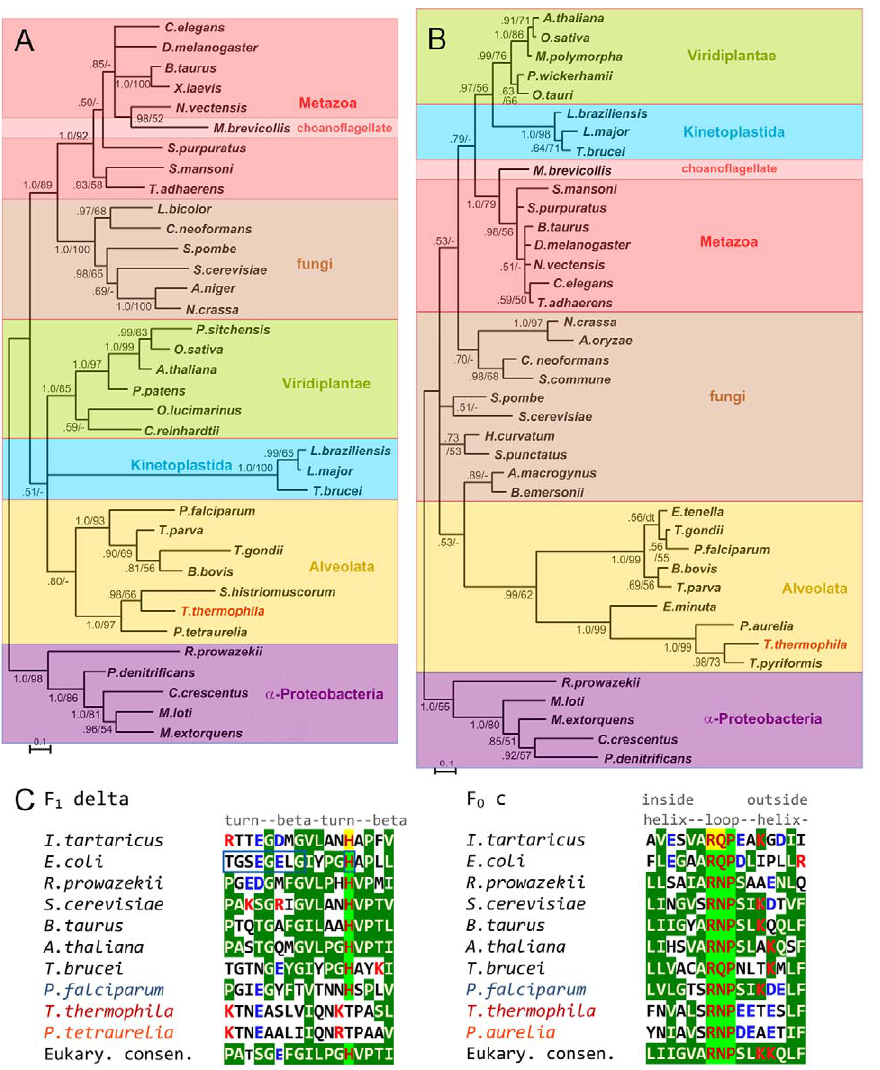
Figure 5. Phylogenetic trees inferred for subunits c and c and alignment of the interface regions of subunits d and c. (A and B) show trees inferred by Bayesian analysis (MrBayes [76], see Methods) for subunit c and subunit c, respectively. Numbers near branch nodes indicate Bayesian posterior probabilities/maximum likelihood bootstrap support (200 replicates) (maximum likelihood analysis employed PhyML [80] [see Methods] indicates a maximum likelihood support of less than 50%; dt indicates a different branch topology was supported by the maximum likelihood analysis). Branches with less than 0.5 posterior probability have been collapsed to a common node. Sequences from a -proteobacterial spp. were included to provide a root, but turned out not to compose the most divergent clade in each analysis; the trees are nevertheless shown as rooted by the bacterial clade. Major taxonomic groups are indicated by color shading (it should be kept in mind, however, that gene product trees can differ from species trees via a number of biological mechanisms, as well as methodological and statistical error). The bar at the lower left provides the scale of substitutions per site. (C) compares the interface regions of subunits d (denoted e in prokaryotes) and c from selected prokaryotic and eukaryotic spp. Amino acid residues determined to be critical for interaction by site directed mutagenesis [49] are shown in dark red with a yellow background. Highly conserved residues are dark red on a light green background; those that are identical to or chemically similar to the consensus amino acid are shown with reverse coloration on a green background. (Consensus residues were calculated in Jalview 2.4 [96] using alignments of representative eukaryotic spp. from a broad range of taxa, but omitting ciliates. Consensus is not indicated for two positions of subunit d that have a very low degree of conservation). Residues of subunit e that were shown to be in proximity to the loop region of subunit c by cross-linking in the E. coli complex [48,97] are enclosed in boxes. Basic (positive) residues are colored red, and acidic (negative) residues blue. Positions of secondary structural elements as found in high resolution structures of bacterial subunits [98,99] are indicated above the alignment. Ciliate species names are shown with red-shaded lettering and P. falciparum , another alveolate, with blue lettering. doi:10.1371/journal.pbio.1000418.g005 have missed some of the component proteins, those that we did Subunit Proteins of ATP Synthase detect could be assigned with a reasonable degree of confidence as We were able to resolve the large mitochondrial complexes being subunits of the complex. Of the 24 proteins present in spot through 2-D BN/BN-PAGE, which permitted a proteomic 1, 22 are the likely constituents of the ATP synthase. Only six of cataloguing of the subunit proteins that constitute T. thermophila these were annotated as subunits of ATP synthase. On the basis of ATP synthase. While it is possible that the proteomic analysis may